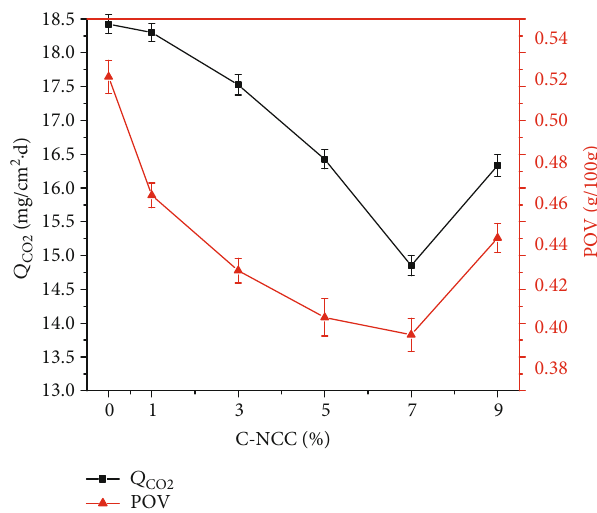
Figure 3: E ff ect of the C-NCC content on the carbon dioxide permeability rate and oxygen permeability of the composite fi